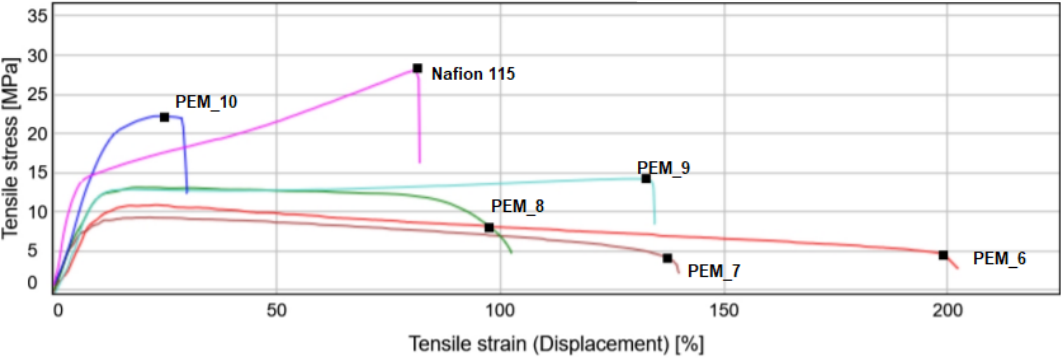
Figure 13. Stress-strain curve for Group 2 SBC membrane families.